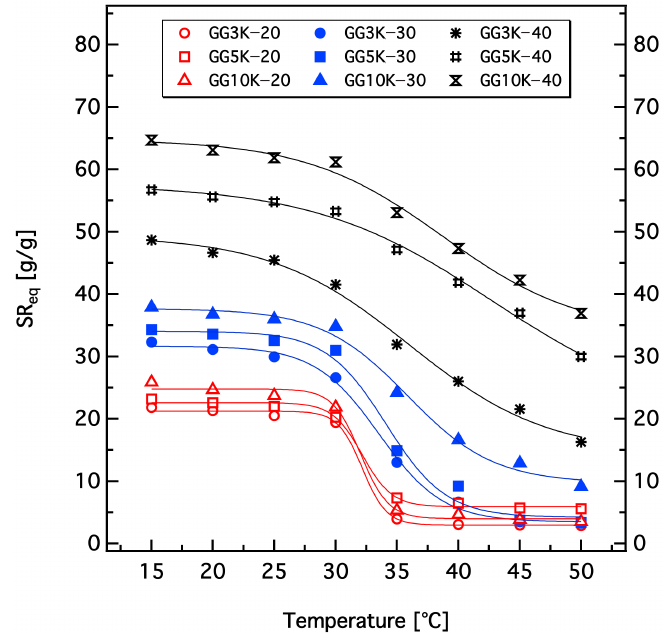
Figure 10. Equilibrium swelling ratio ( SR eq ) of hydrogels as a function of temperature in deionised water. The lines are fit of a sigmoid function to the raw